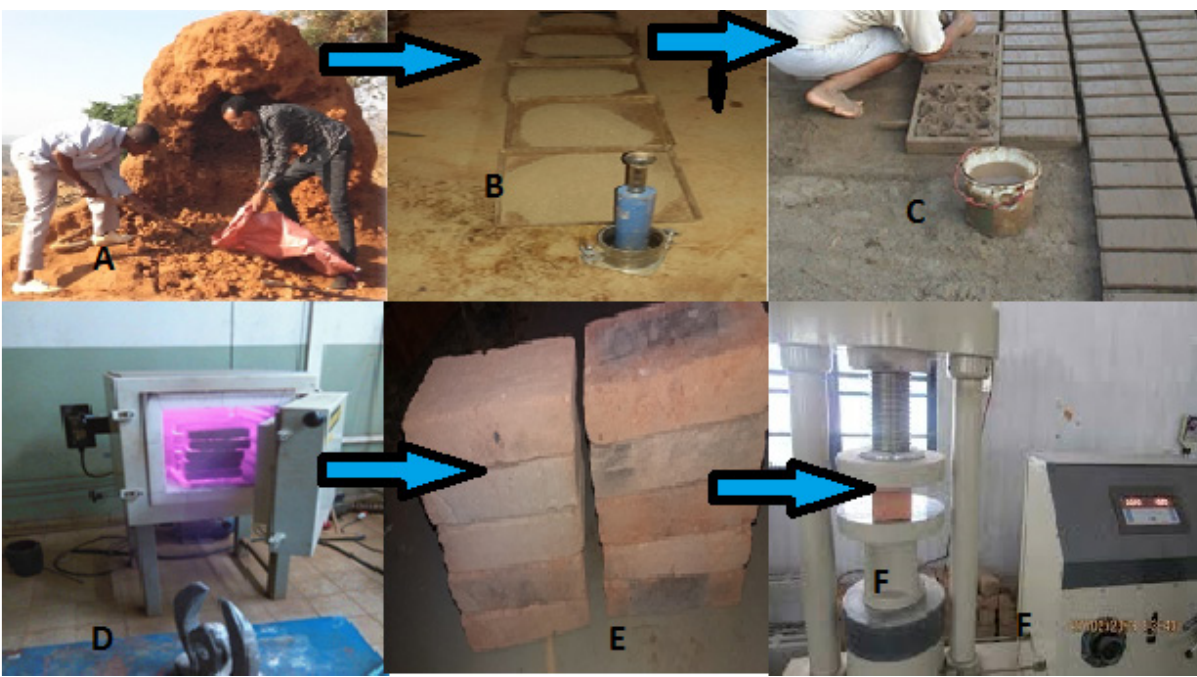
Figure 3: TMSs bricks production characterisation process: A = Sample collection; B = Preparation; C = Moulding; D = Firing; E = Fired bricks; and F = Compressive strength.